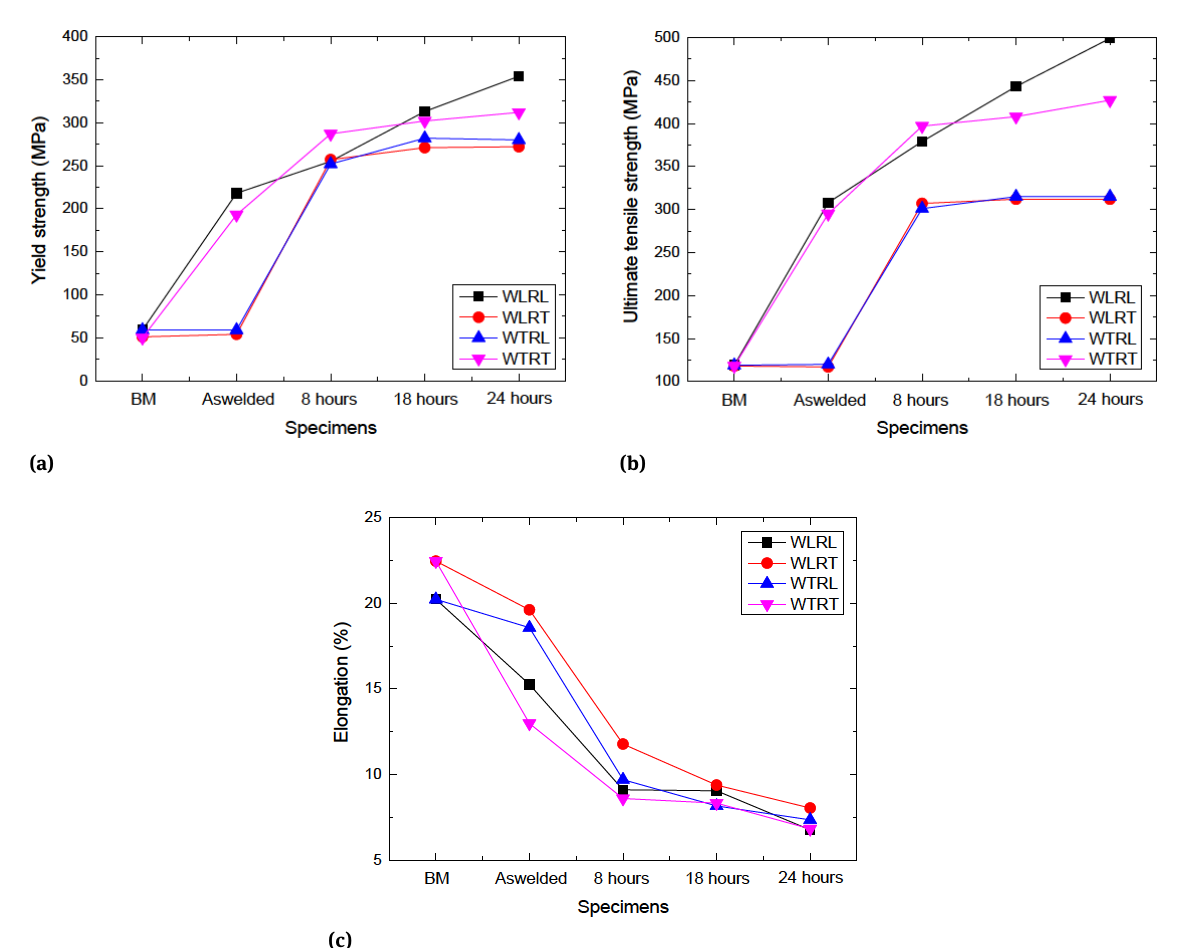
Figure 10: The tensile test results of the AL6061-T6 at RT; (a) Yield strength, (b) Ultimate tensile strength, and (c) Elongation.